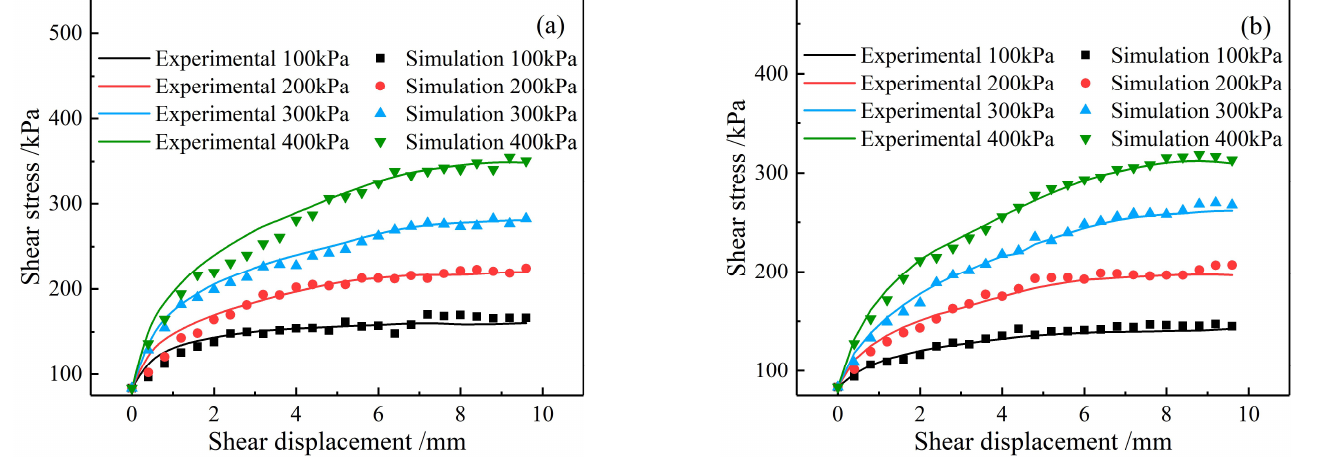
Figure 13. τ - δ curves: ( a ) N-L; ( b )